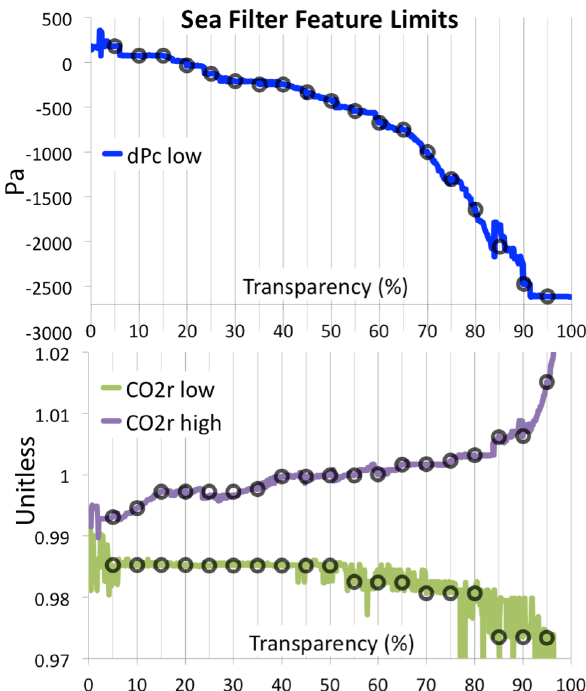
Figure 12. Sea data sub-filter thresholds for dPc (top) and CO2r (bottom). Black circles show 2 Fig. 12. Sea data subfilter thresholds for dPc (top) and CO2r (bot- monotonic, hand-smoothed final sub-filter values. Note that the high threshold for dPc was 3 tom). Black circles show monotonic, hand-smoothed final subfilter not needed, as can be explained in Fig. 7, bottom. 4 values. Note that the high threshold for dPc was not needed, as can be explained in Fig. 7, bottom.